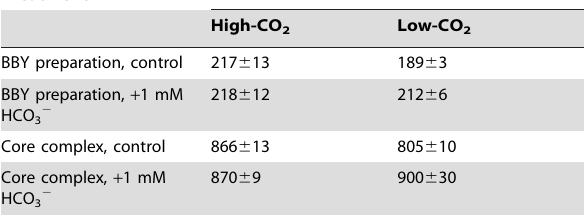
Table 2. Light-saturated O 2 evolution rates in both BBY preparations and PSII core complex isolated from high- and low-CO 2 C. reinhardtii cells.